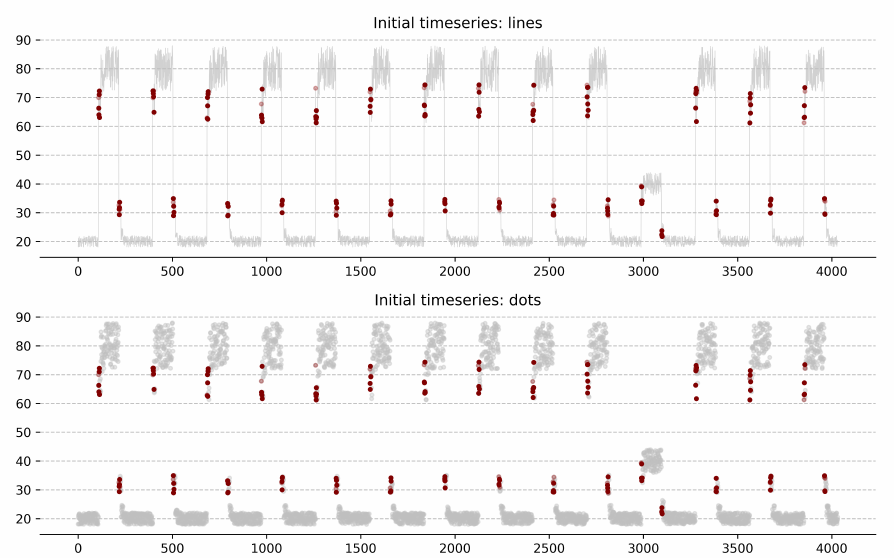
Figure 20. Numenta Anomaly Benchmark time series with anomalies in the seasonal component.